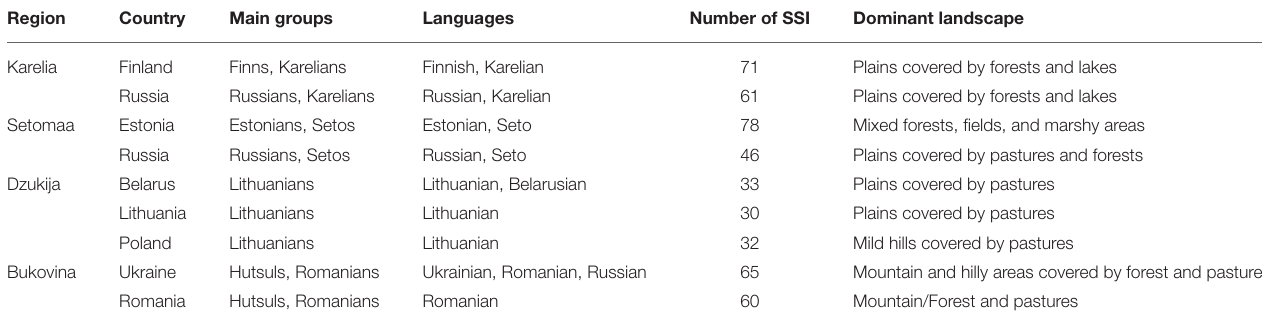
TABLE 1 | Main characteristics of the study area.